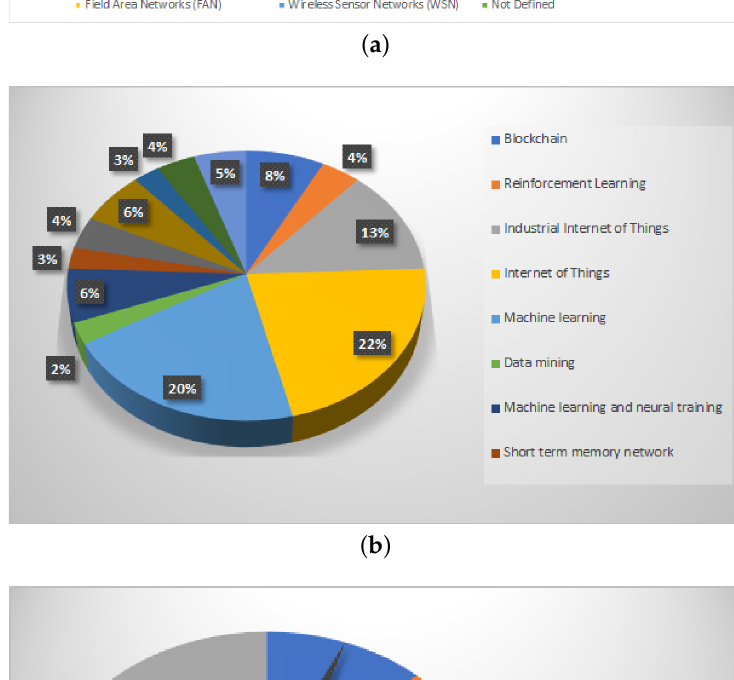
Table 5. Articles that can be classified by means of their data transmissions over